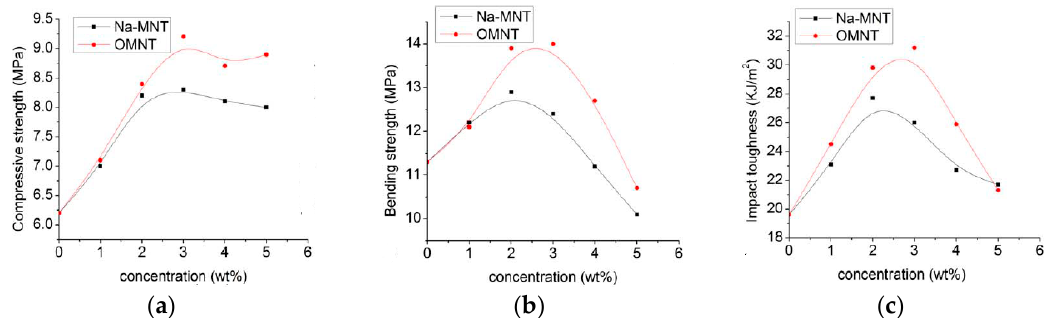
Figure 5. Effect of natural unmodified montmorillonite (Na-MMT) and organo-modified layered montmorillonite (OMMT) on mechanical properties: compressive strength ( a ), bending strength ( b ) and impact toughness ( c ) of PLA/polybutylene succinate (PBS) foams [40], Reproduced with permission Figure 2014.